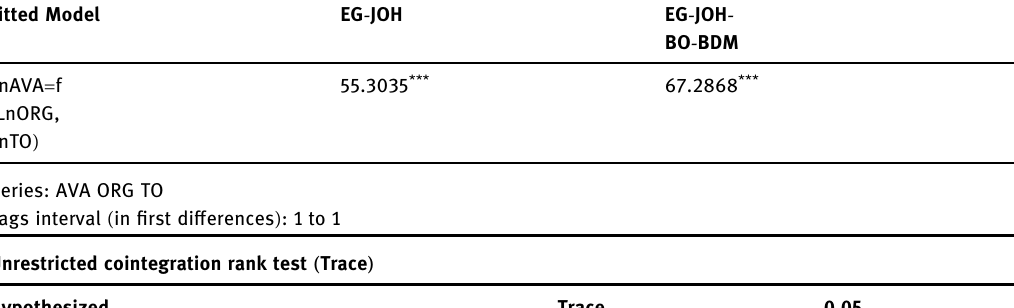
Table 4: Bayer and Hanck ( 2013 ) /Johansen Cointegration Test Fitted Model Cointegration